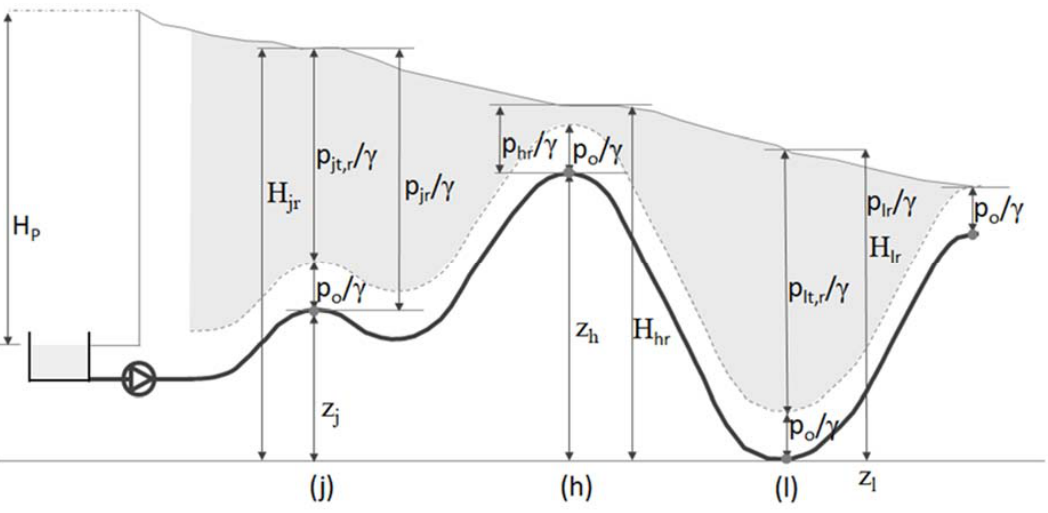
Figure 3. Topographic energy concept in a real system (from Cabrera et al. [16]).